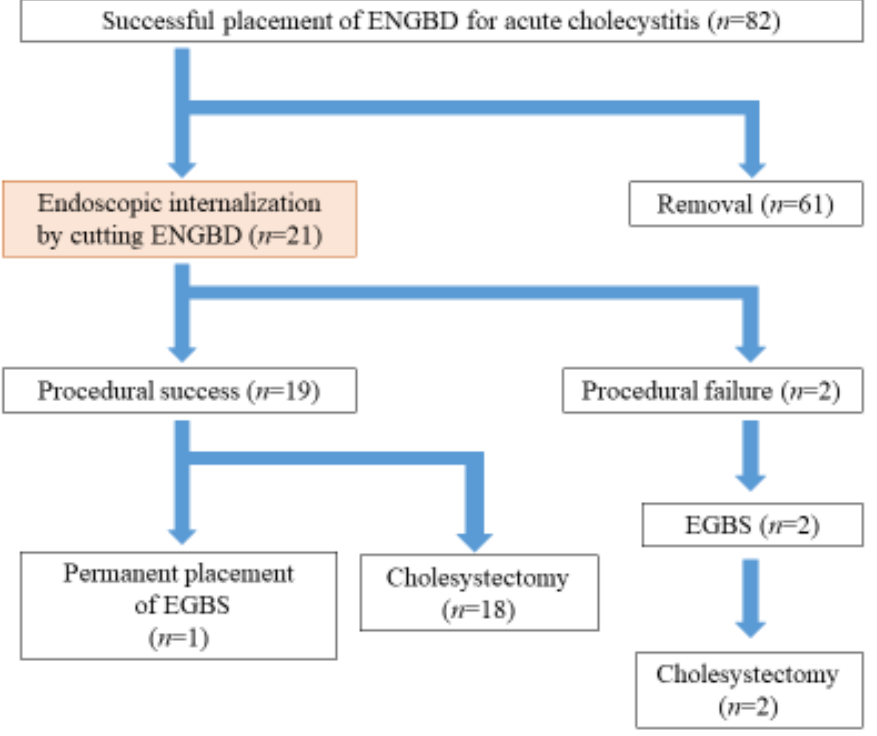
Figure 3. The flow of the patients. ENGBD, endoscopic nasogallbladder drainage; EGBS, endoscopic gallbladder stenting.